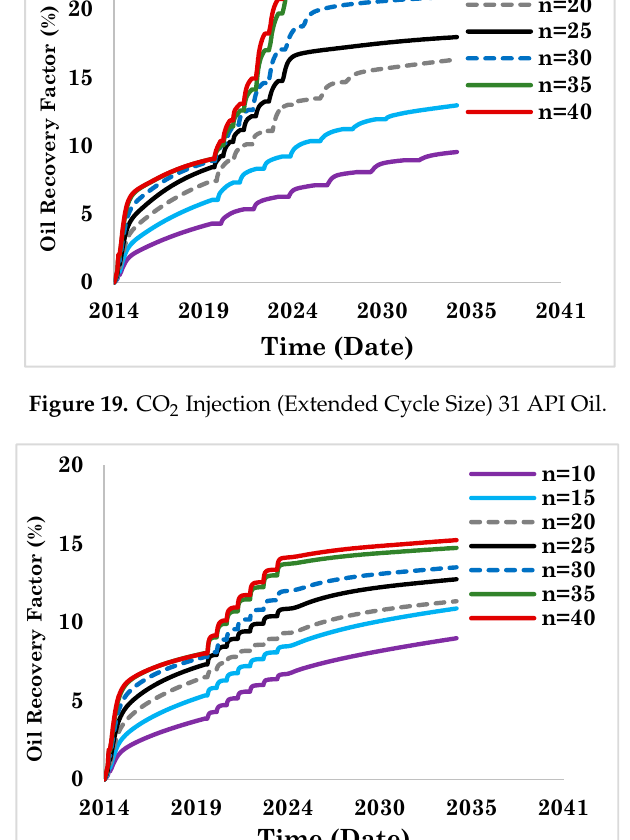
Figure 20. NG Injection (Fixed Cycle Size) 31 API Oil.